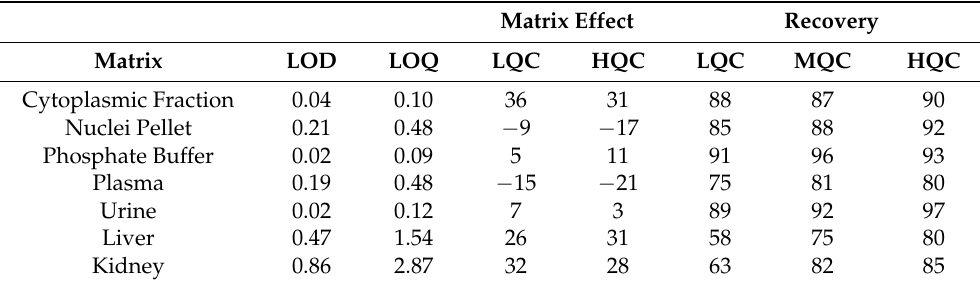
Table 1. Limit of the assay: LOD (Limit of Detection expressed in ng/mL) and LOQ (Limit of Quantification expressed in ng/mL). Recovery expressed as percentage and matrix effect expressed as a percentage of ion suppression (-) or enhancement.